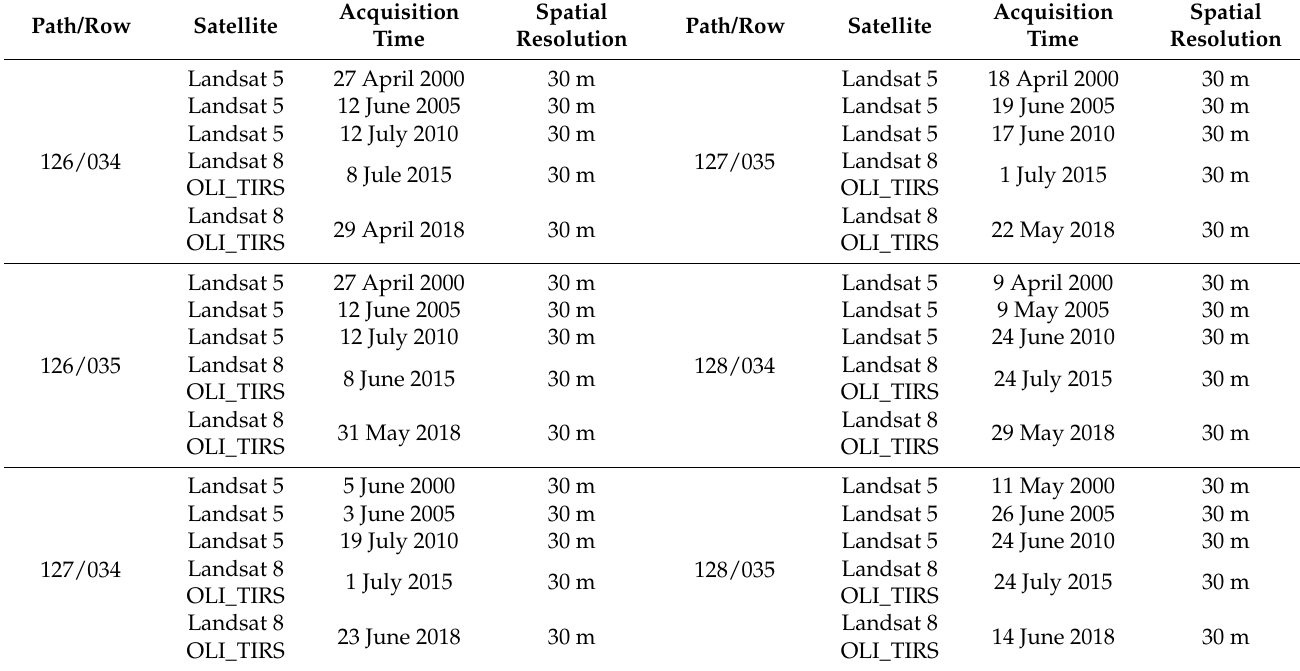
Table 2. The details of collected satellite images (cloudage ≤ 5%) for the classifications of land use types, including path/row, acquisition time (day month year), and spatial resolution of satellite data.